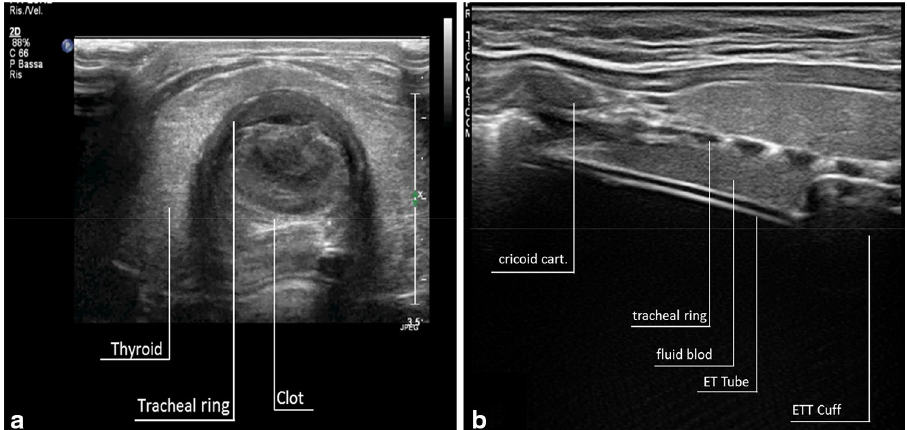
Fig. 1 a Large clot inside the trachea. It appears as a slightly inhomogeneous echo‑structure consisting of hyperechoic and hypoechoic areas. b Uncoagulated blood over the cuff after difficult